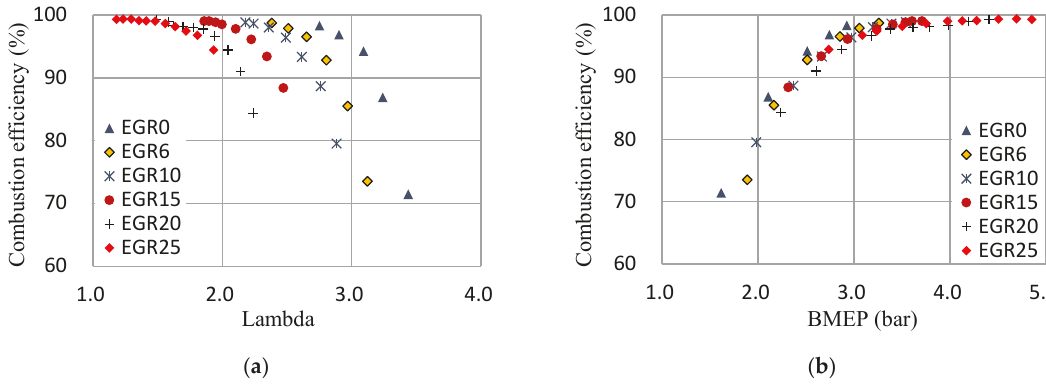
Figure 7. Combustion efficiency with respect to: ( a ) Lambda; ( b ) BMEP.